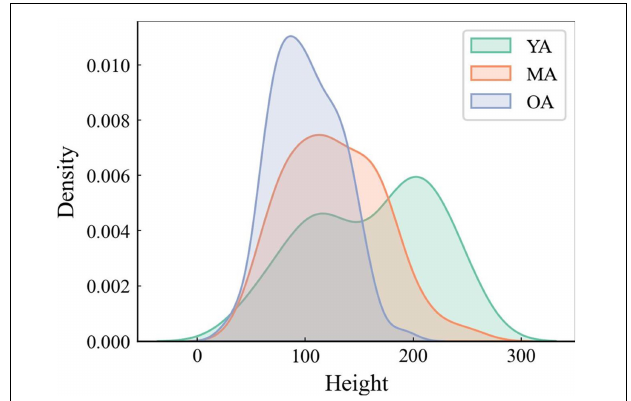
FIGURE 2 | The average height of strokes analysis through DBNet algorithm. Note that the average height of strokes is smaller in OA than in MA and YA.